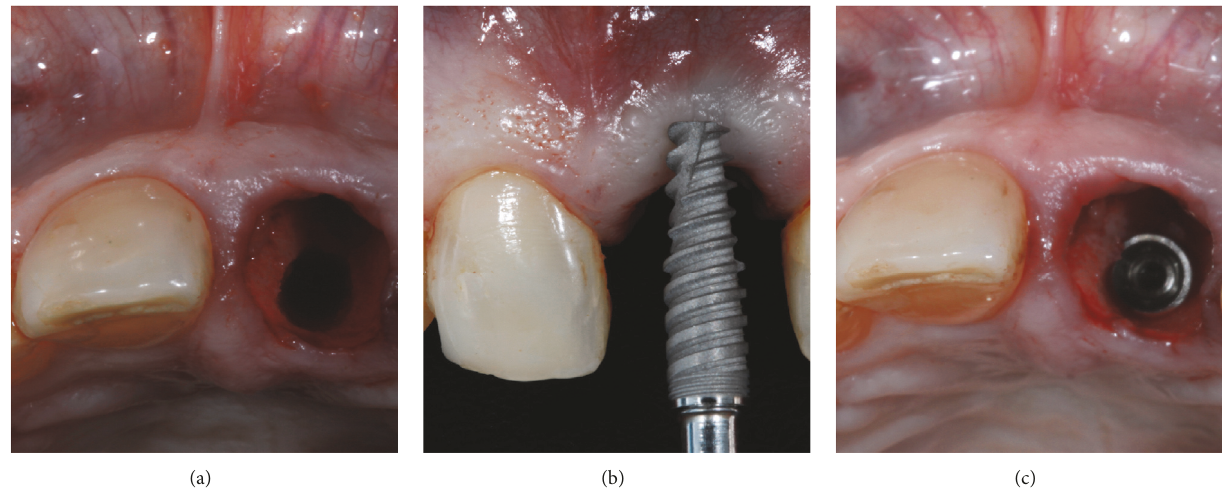
Figure 3: After atraumatic tooth extraction the palatal bone was drilled (a) and a 3.5 × 13mm was installed (b) 4mm below the buccal gingival margin (c).